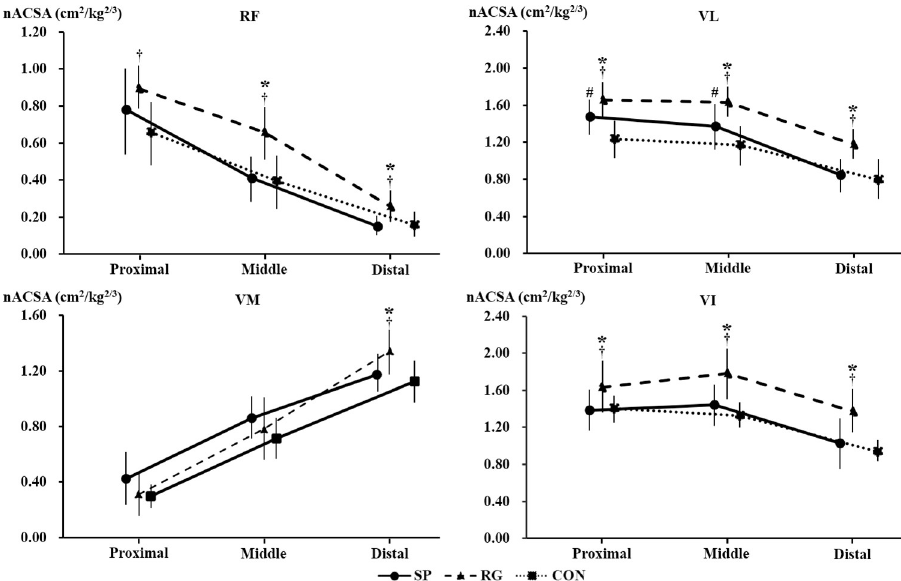
Fig 5. The normalized anatomical cross-sectional area in each region of the rectus femoris (RF), the vastus lateralis (VL), the vastus medialis (VM), and the vastus intermedius (VI) in the sprinters (SP), rugby players (RG), and non-athletes (CON). � Significant difference between the sprinters and the rugby players. #Significant difference between the sprinters and the non-athletes. †Significant difference between the rugby players and the non-athletes.